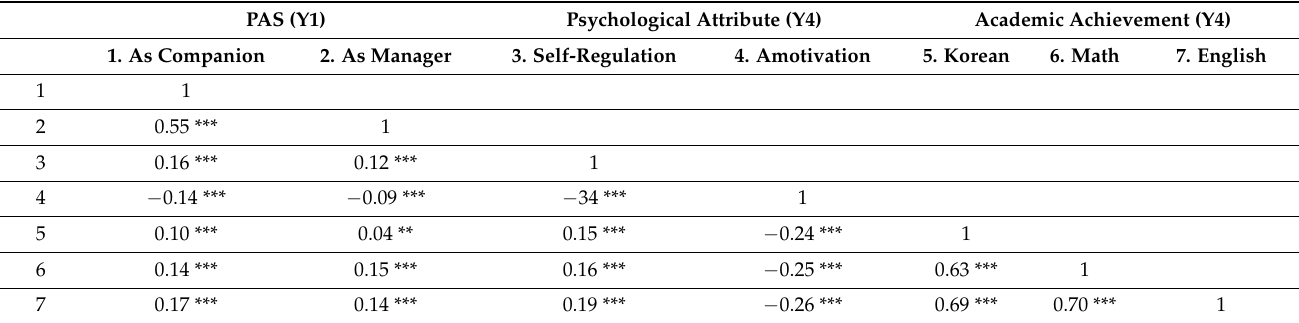
Table 3. Correlations of PAS with Adolescents’ Psychological Attribute and School